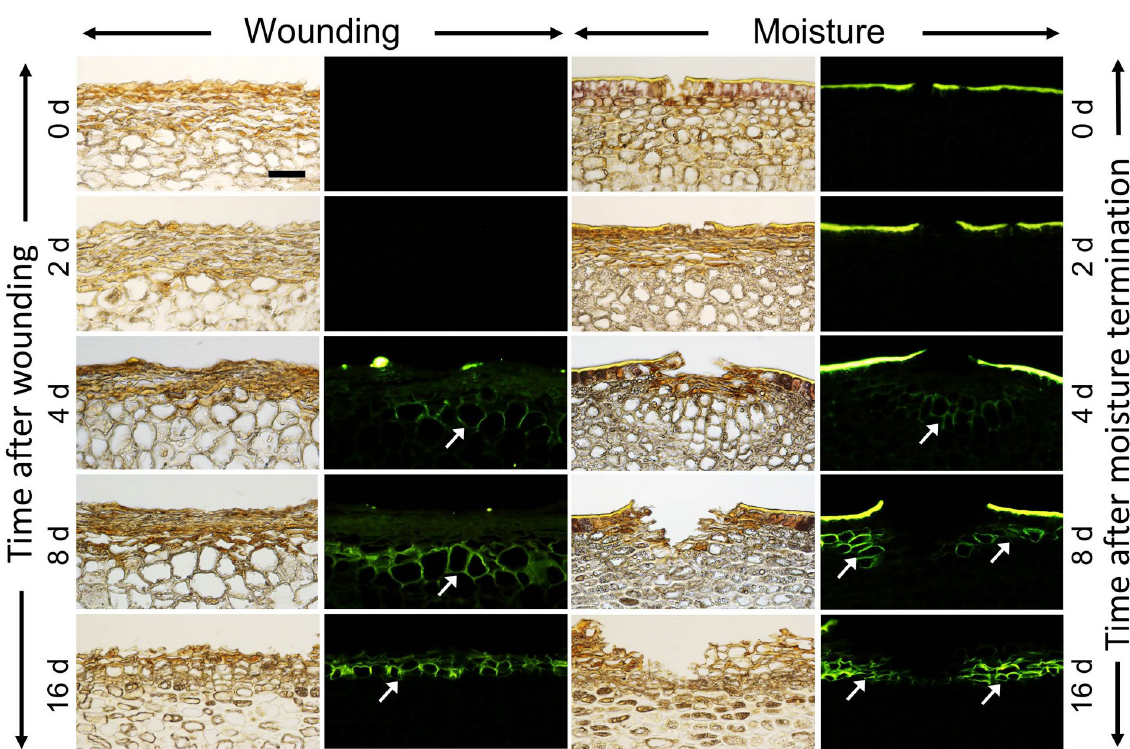
Fig 2. Time course of periderm development following wounding (left panel) and moisture exposure (right panel) of skin patches of ‘Pinova’ apple. Patches of skin were abraded 40 days after full bloom (DAFB) using fine sandpaper. Microcracks induced by surface moisture served as control (‘Moisture’). Here, the fruit surface was exposed to surface moisture for 12 d from 28 to 40 DAFB. Pairs of micrographs were taken under transmitted white light or incident fluorescent light (filter module U-MWB) after staining with Fluorol Yellow. Fluorol Yellow stains the cuticle and suberized cell walls. Scale bar equals 50 μ m and is representative for all images of the composite.